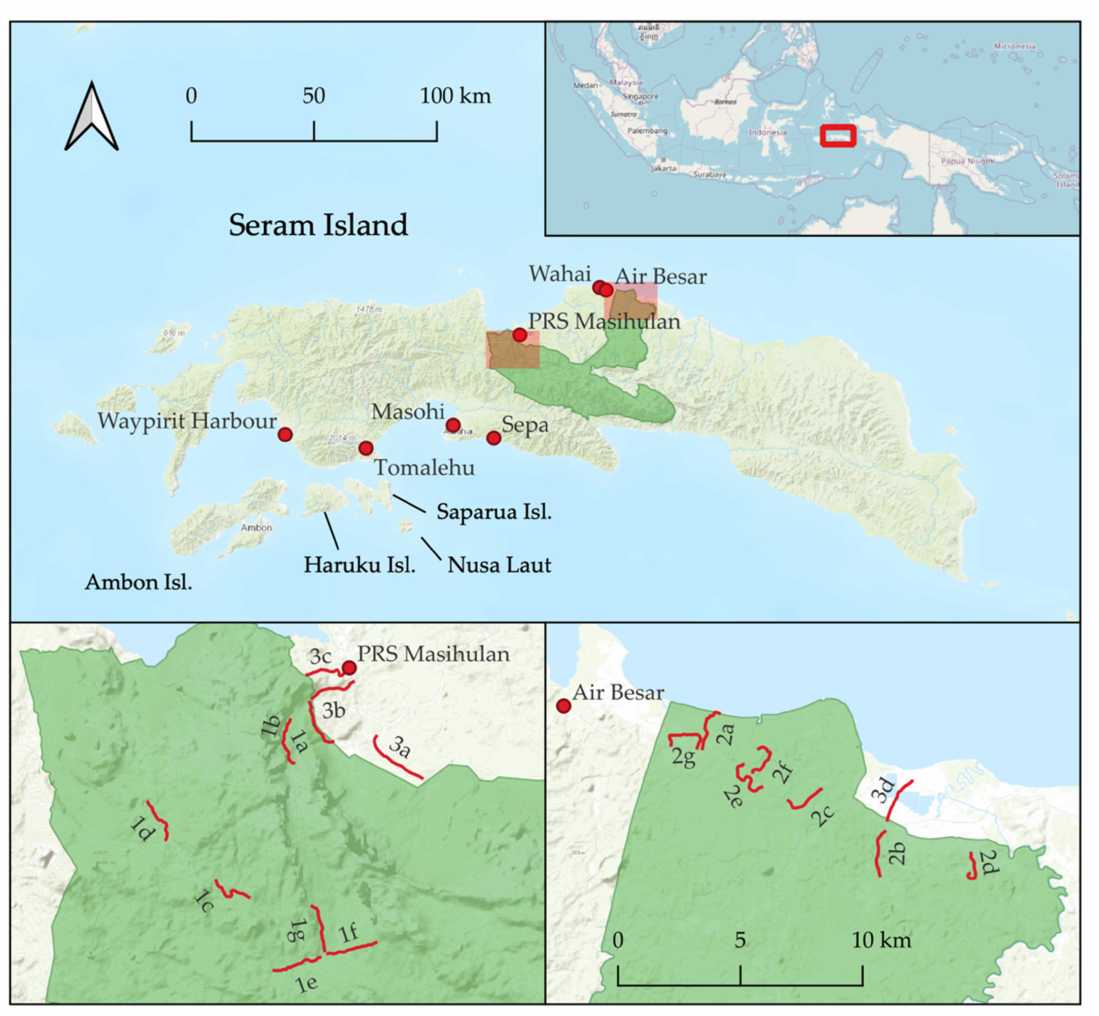
Figure 1. Map of the study area in Seram Island, Indonesia with the Manusela National Park (green). Census transects represent (1) Masihulan Camp sites: (1a) Masihulan camp track, (1b) Pos pantau, (1c) Km 20, (1d) Hatusaka track, (1e) Illie Camp track 2, (1f) -track 3, (1g) -track 1; (2) Sasarata Camp sites: (2a) Mangrove track, (2b) Wae Masin, (2c) Wae Mual, (2d) Pasahari fire track, (2e) Wae Patan, (2f) Wae Faung, (2g) Wae Masinatu; and (3) Manusela NP buffer zone (BZ) sites: (3a) Negeri Masihulan (NM) Galian C, (3b) NM shelter track, (3c) NM cultivation, (3d) Negeri Pasahari Wae Masin. Red dots represent locations mentioned in the main